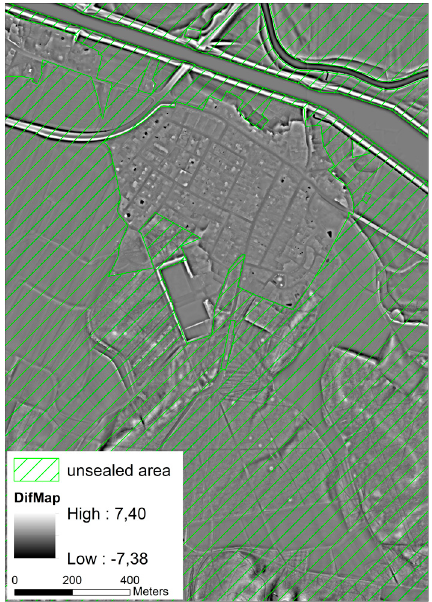
Figure 5. Difference Map of a part of the investigation area in Haltern. The search is limited to the areas that are unsealed (green). The others, primarily settlements, are not considered